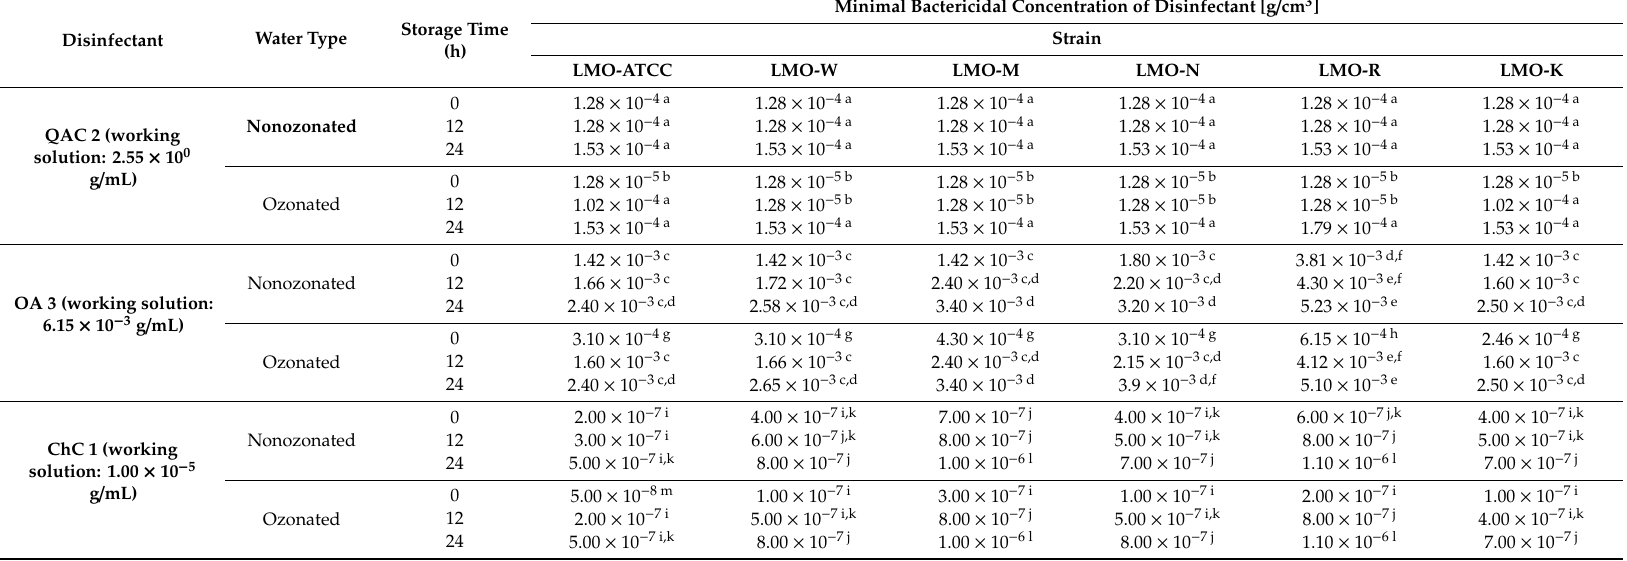
Table 6. Stability assessment of stored solutions of QAC 2, OA 3, and ChC 1 after 0. 12 and 24